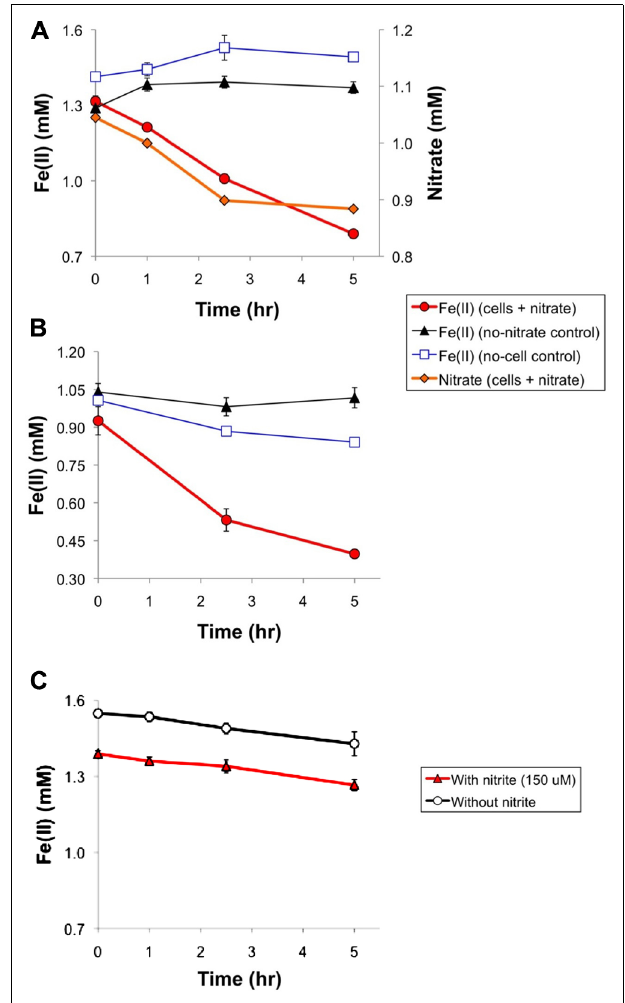
FIGURE 1 |Anaerobic cell suspension studies of nitrate-dependent Fe(II) oxidation by wild-type T. denitrificans and related abiotic studies. (A) Cell suspensions with the headspace consisting of the standard glove box atmosphere (nominally 85% N 2 – 10% CO 2 – 5% H 2 ), (B) cell suspensions with ultra high-purity N 2 in the headspace, and (C) abiotic studies (without T. denitrificans cells) under the same conditions as in (A) but with 150 μ M nitrite (the typical amount of nitrate consumed in cell suspension experiments) replacing 1 mM nitrate.The OD 600 of the experiments represented by (A) and (B) was 1.8. Data points represent the averages of triplicates and error bars represent one standard deviation.